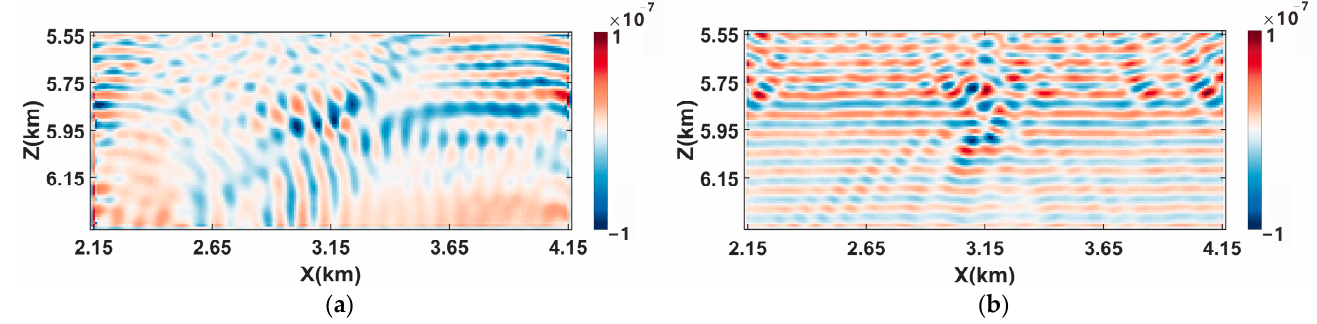
Figure 13. Gradient comparison of VSP-driven local FWI term ( a ) and surface data local FWI term ( b ) at 30 Hz frequency.